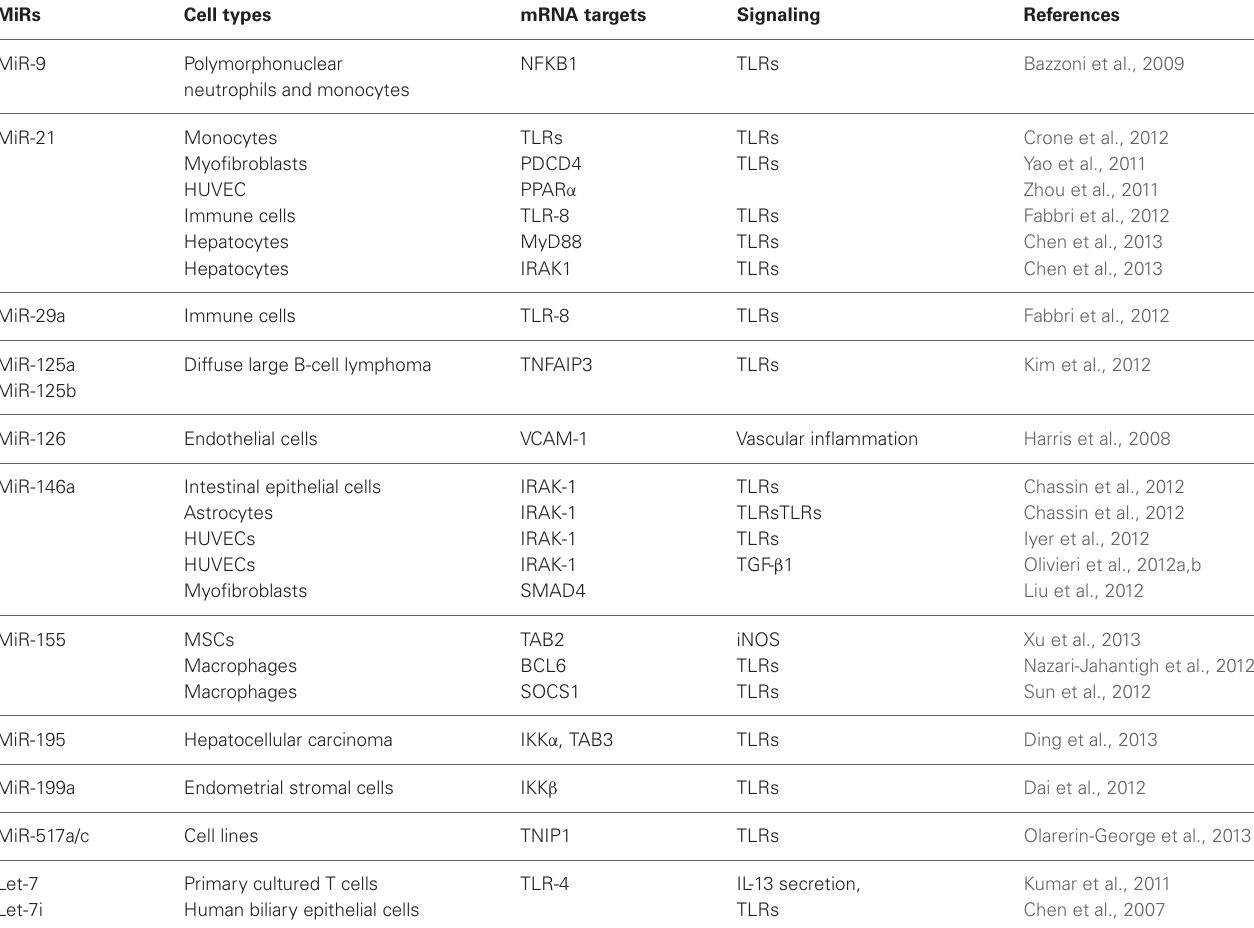
Table 1 | Cellular inflamma-miRs